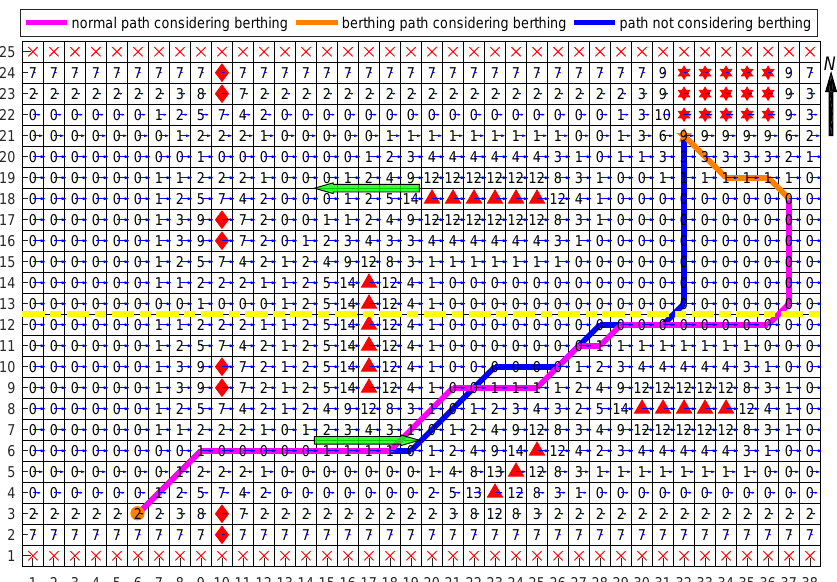
Figure 9. Berthing path generation with an improved A-Star algorithm considering berthing and an A-Star algorithm not considering berthing for vessels (The definition of the graphic symbols in this figure is the same as the definition in Figure